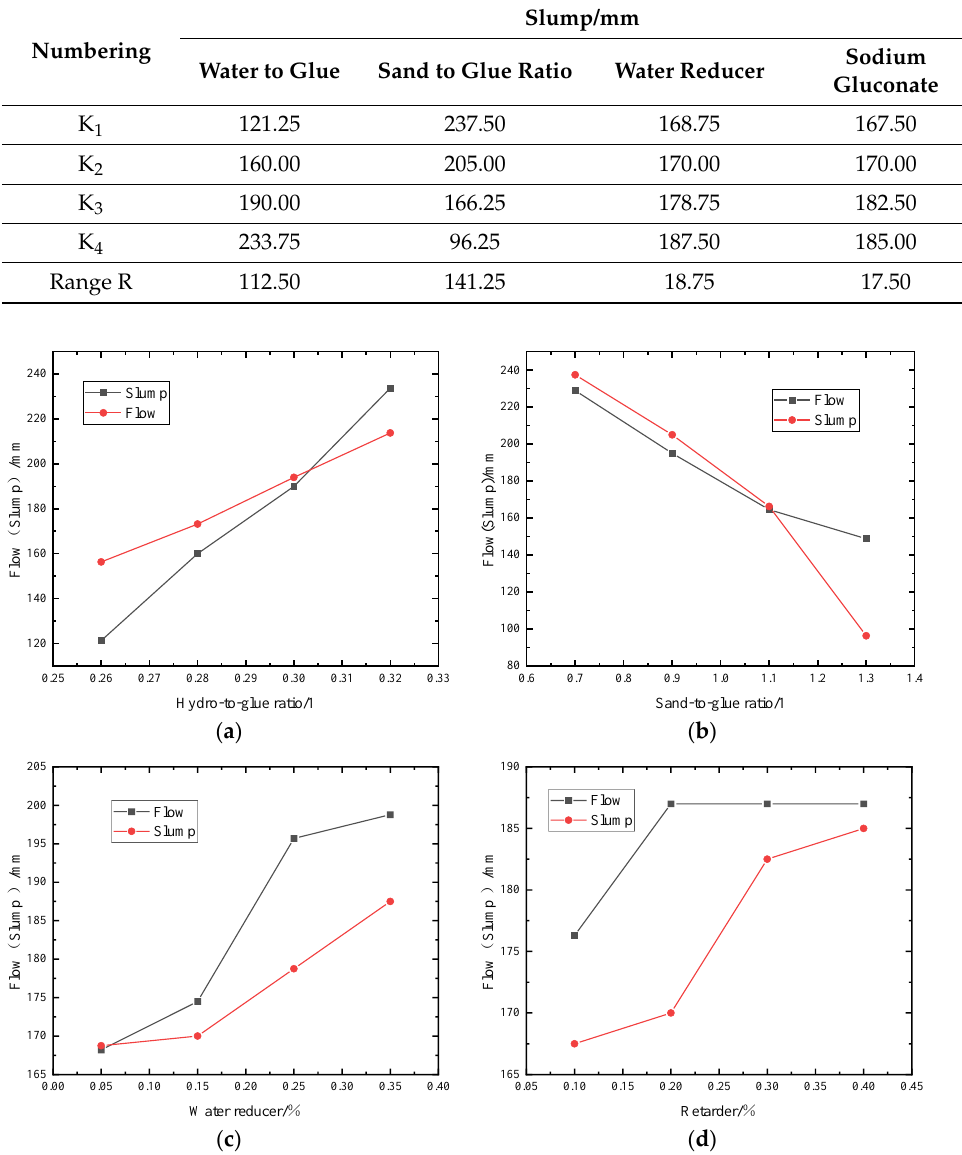
Table 9. Influence of various factors on slump.